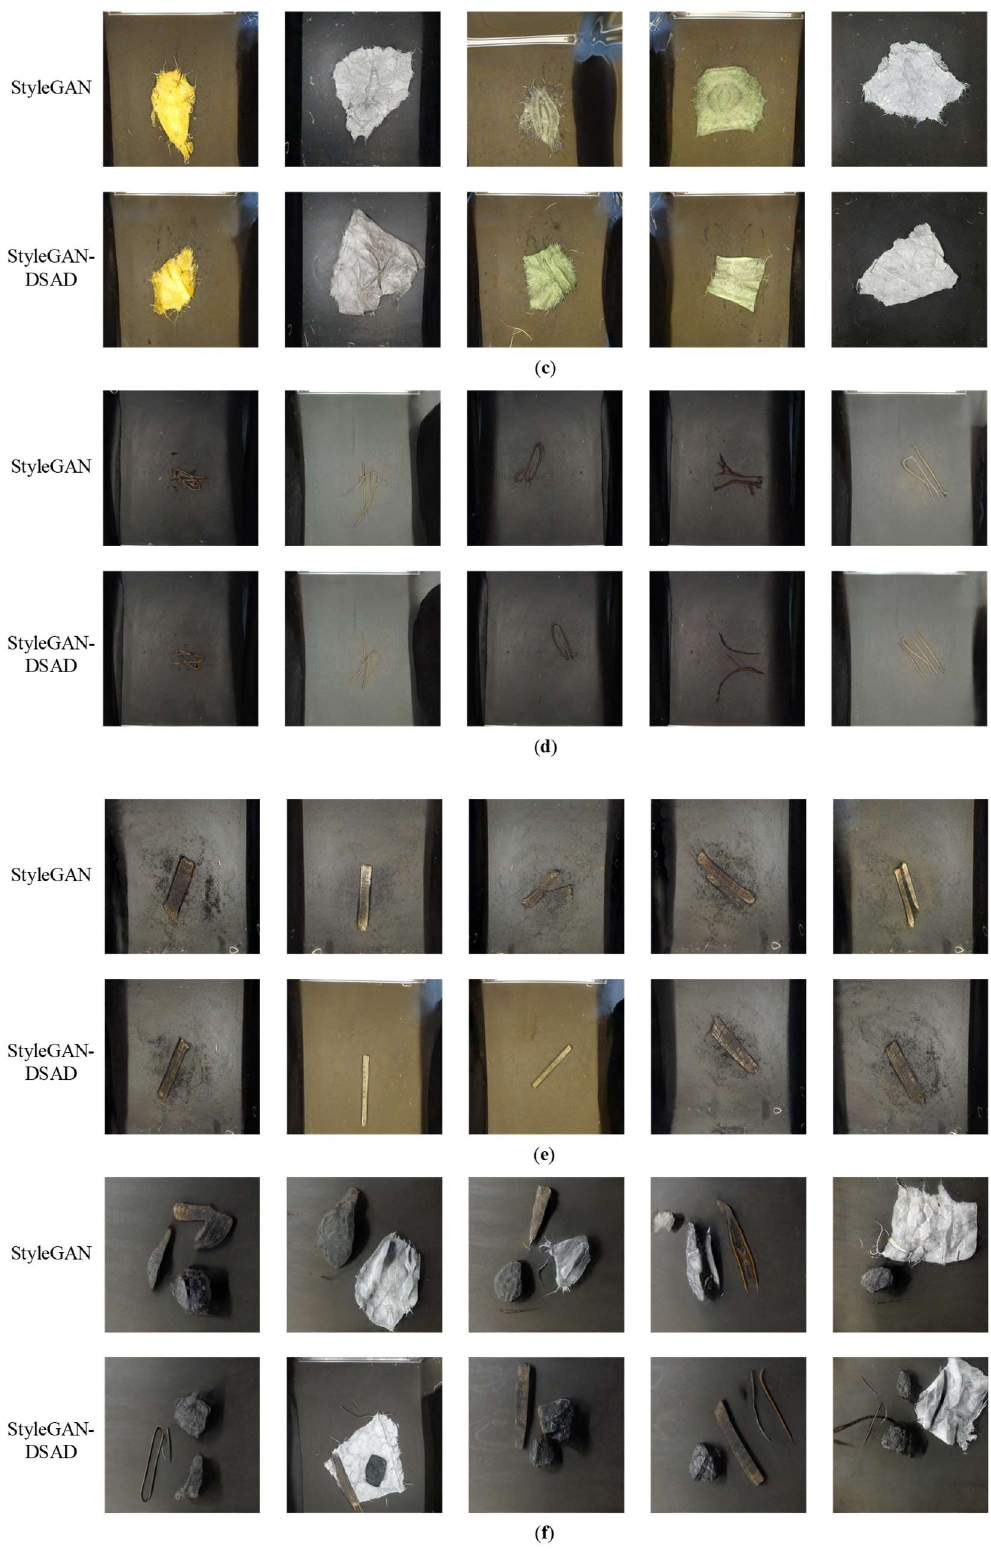
Figure 13. Comparison results of generated images. ( a ) coal; ( b ) gangue; ( c ) bag; ( d ) iron; ( e ) wood; ( f ) all.